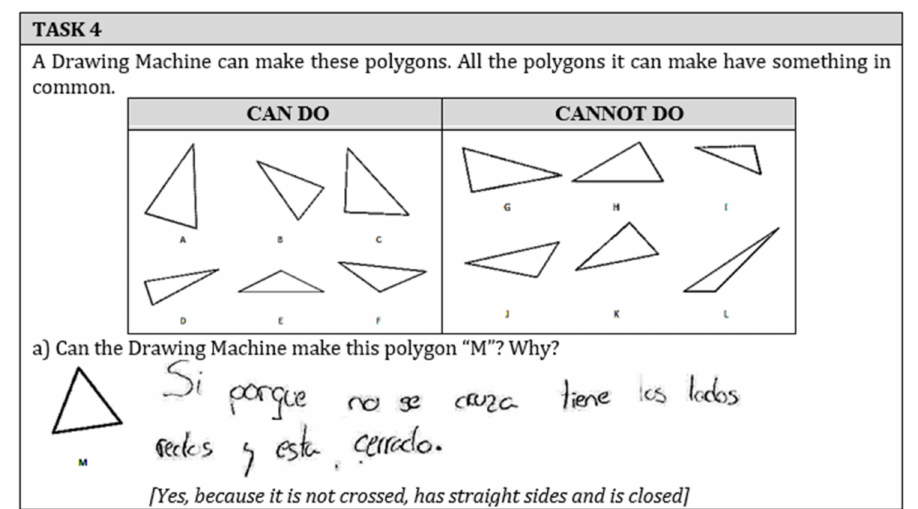
Figure 14. The answer given by student G2S7 when performing the task of recognizing the equilateral triangle as an example of an isosceles triangle (identified class).